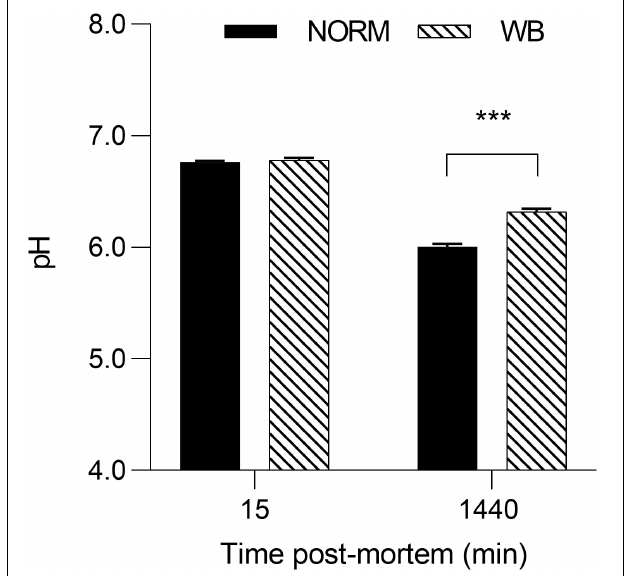
FIGURE 2 | Average pH of unaffected (NORM) and wooden breast (WB) broiler pectoralis major muscles ( n = 12/group) at 15 and 1,440 min post-mortem. Data represent means ± SEM. Asterisks indicate significant difference within the time point (*** P <